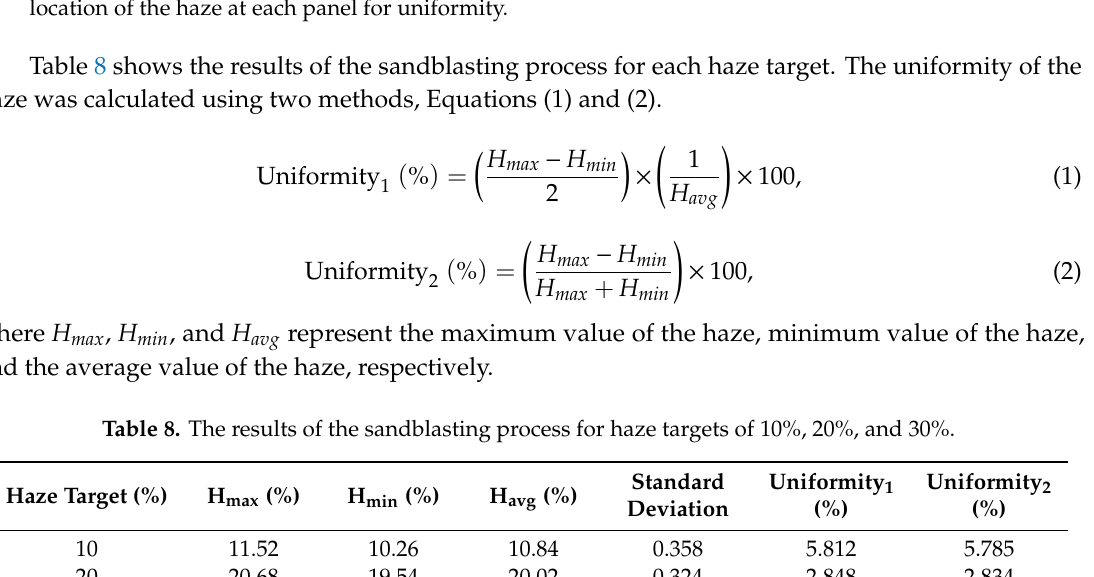
Figure 7. Layout of uniformity test structure: ( a ) Dimensions of panel and samples; ( b ) the measurement location of the haze at each panel for uniformity.